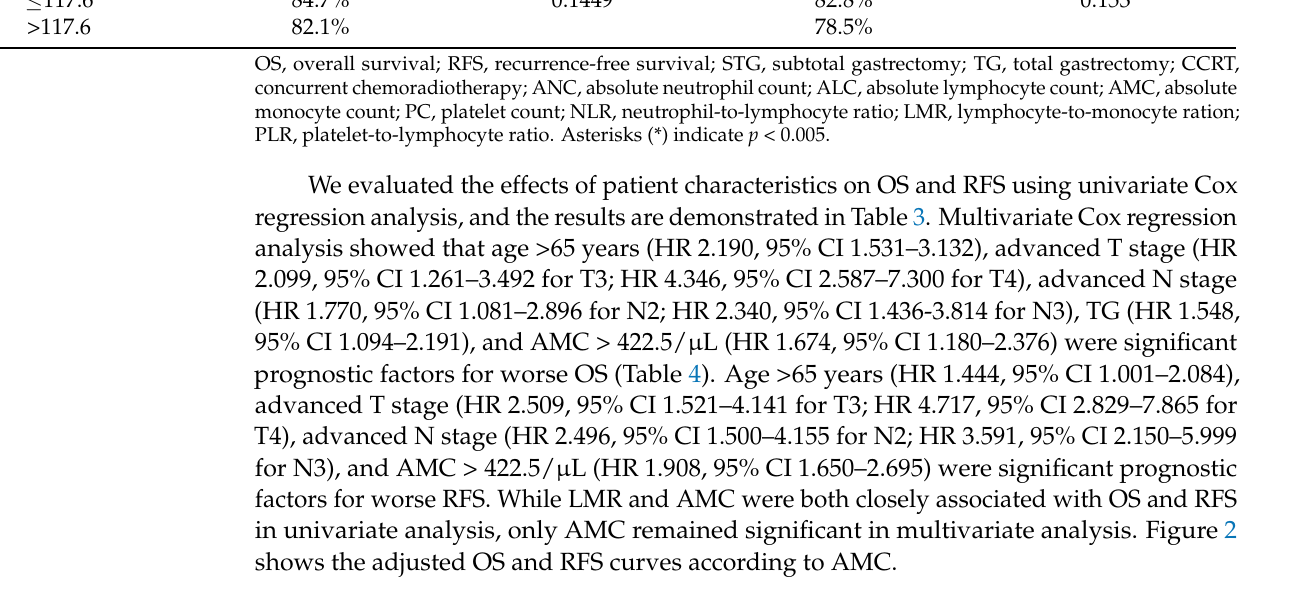
Table 3. Univariate Cox regression analysis for OS and RFS in all patients ( n = 692). OS